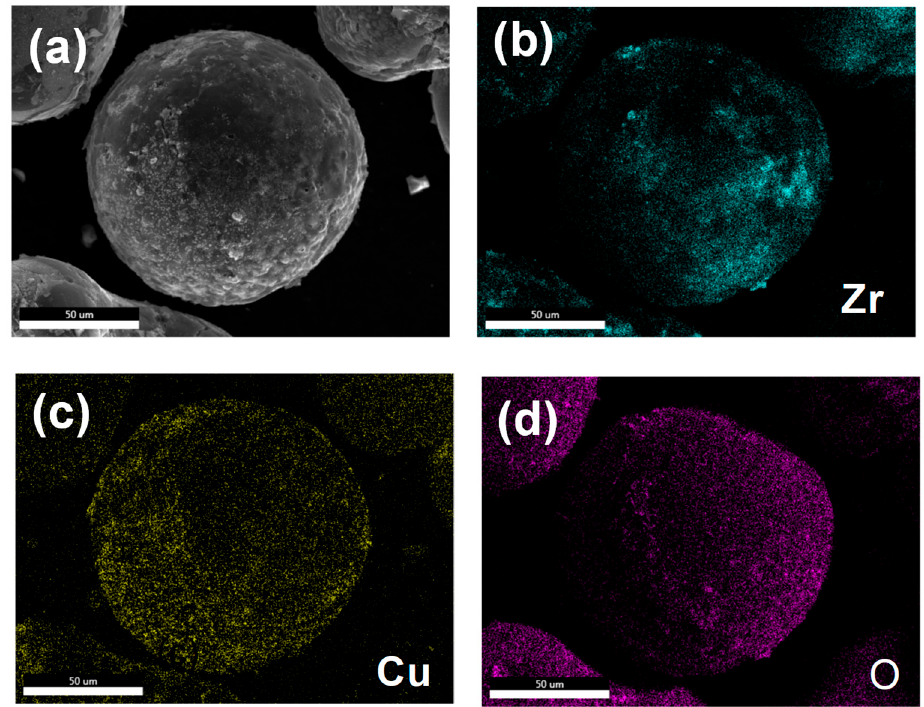
Figure 3. SEM ( a ) and SEM-EDS ( b – d ) images of 0.03-CuO/ZrO 2 /CB/coal-tar-pitch-SAC material. EDS mapping of ( b ) Zr, ( c ) Cu and ( d ) O.